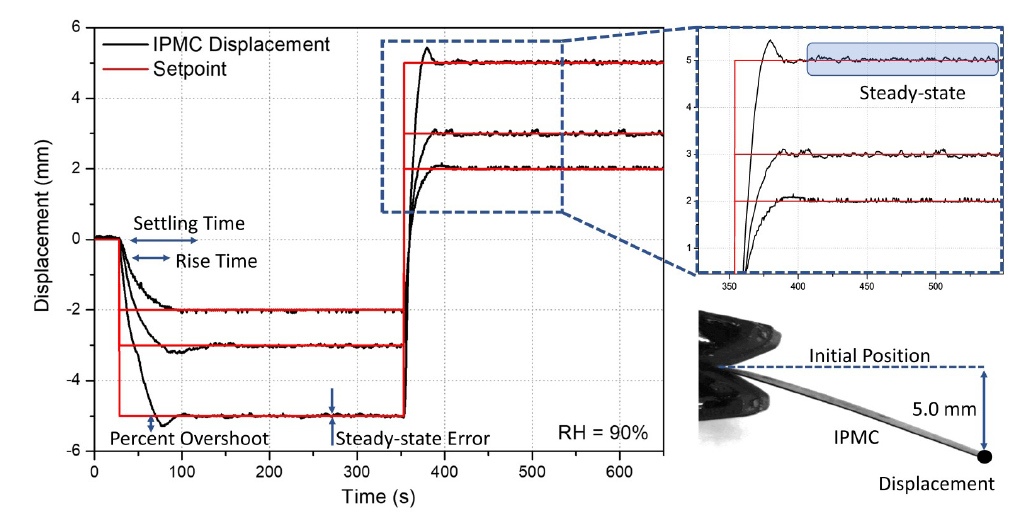
Figure 8. IPMC displacement as a function of Time showing the PI controller